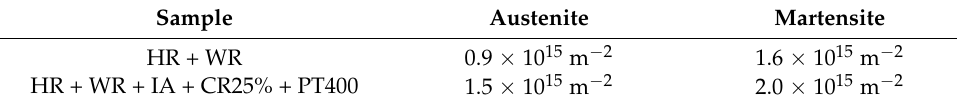
Table 1. The average GND densities of austenite and martensite in three typical samples.